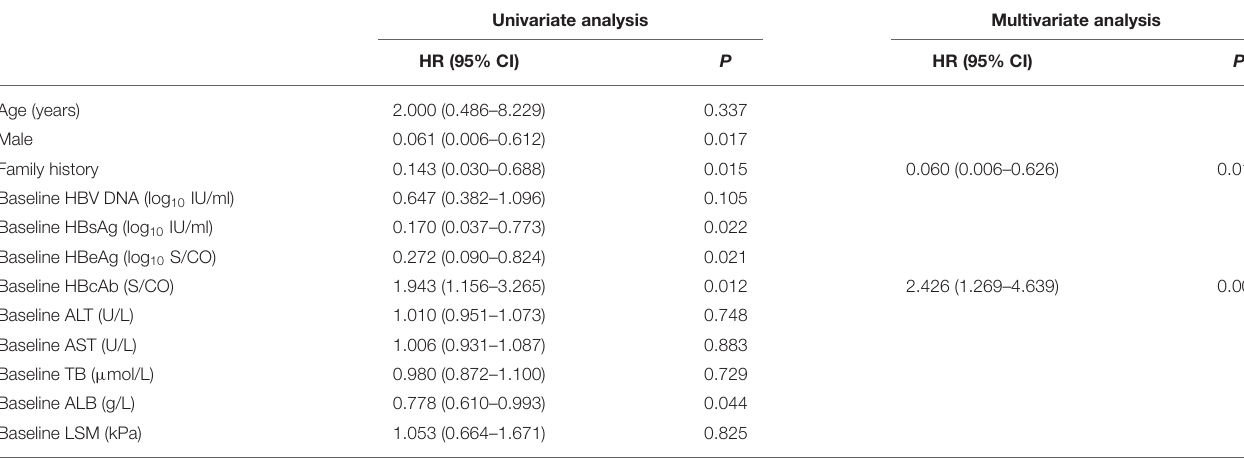
TABLE 3 | Factors predictive of virological response in liver biopsy-proven IT and MA-phase patients. Univariate analysis Multivariate